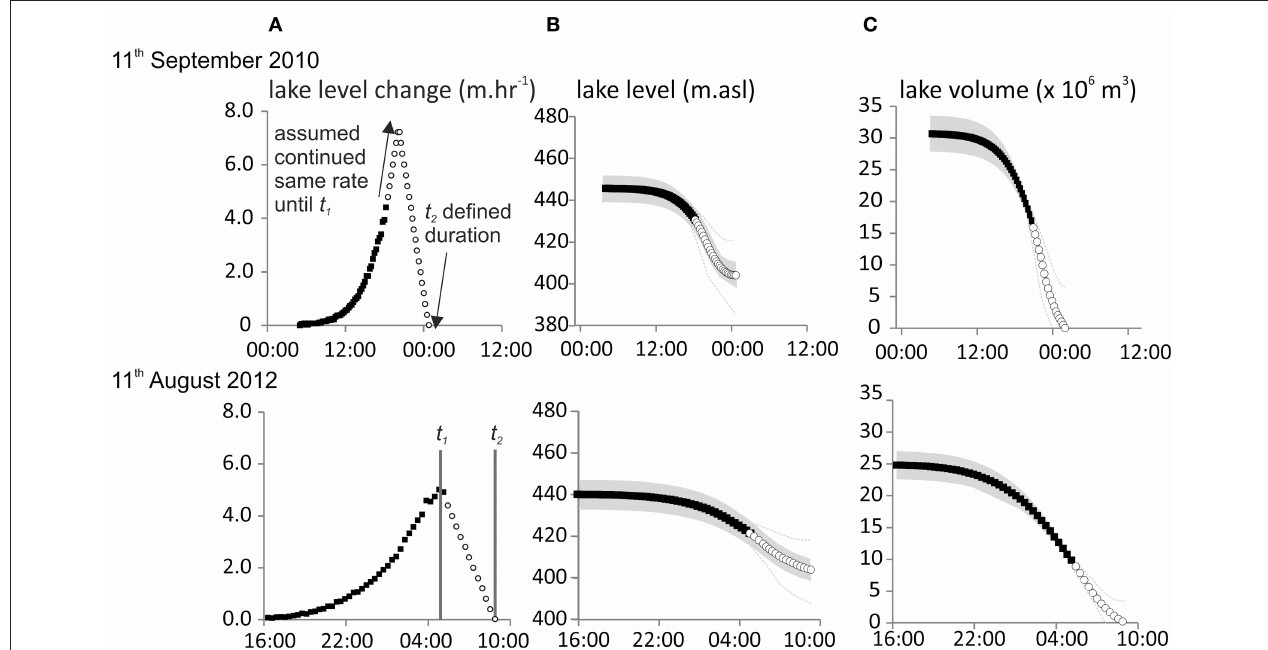
FIGURE 3 | Measured lake outflow (black filled squares) with reconstruction (gray filled circles) of the latter part of each event using rate of change of lake level (A), absolute lake level (B) and lake volume (C). Gray shaded areas are indicative of uncertainty range due to pressure transducer and dashed lines indicate uncertainty range due to reconstructions using downstream gauged data.